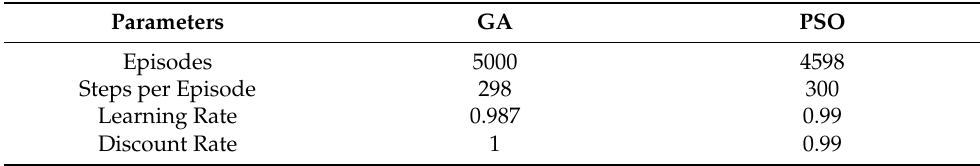
Table 6. Results Obtained from the Optimization Algorithm.